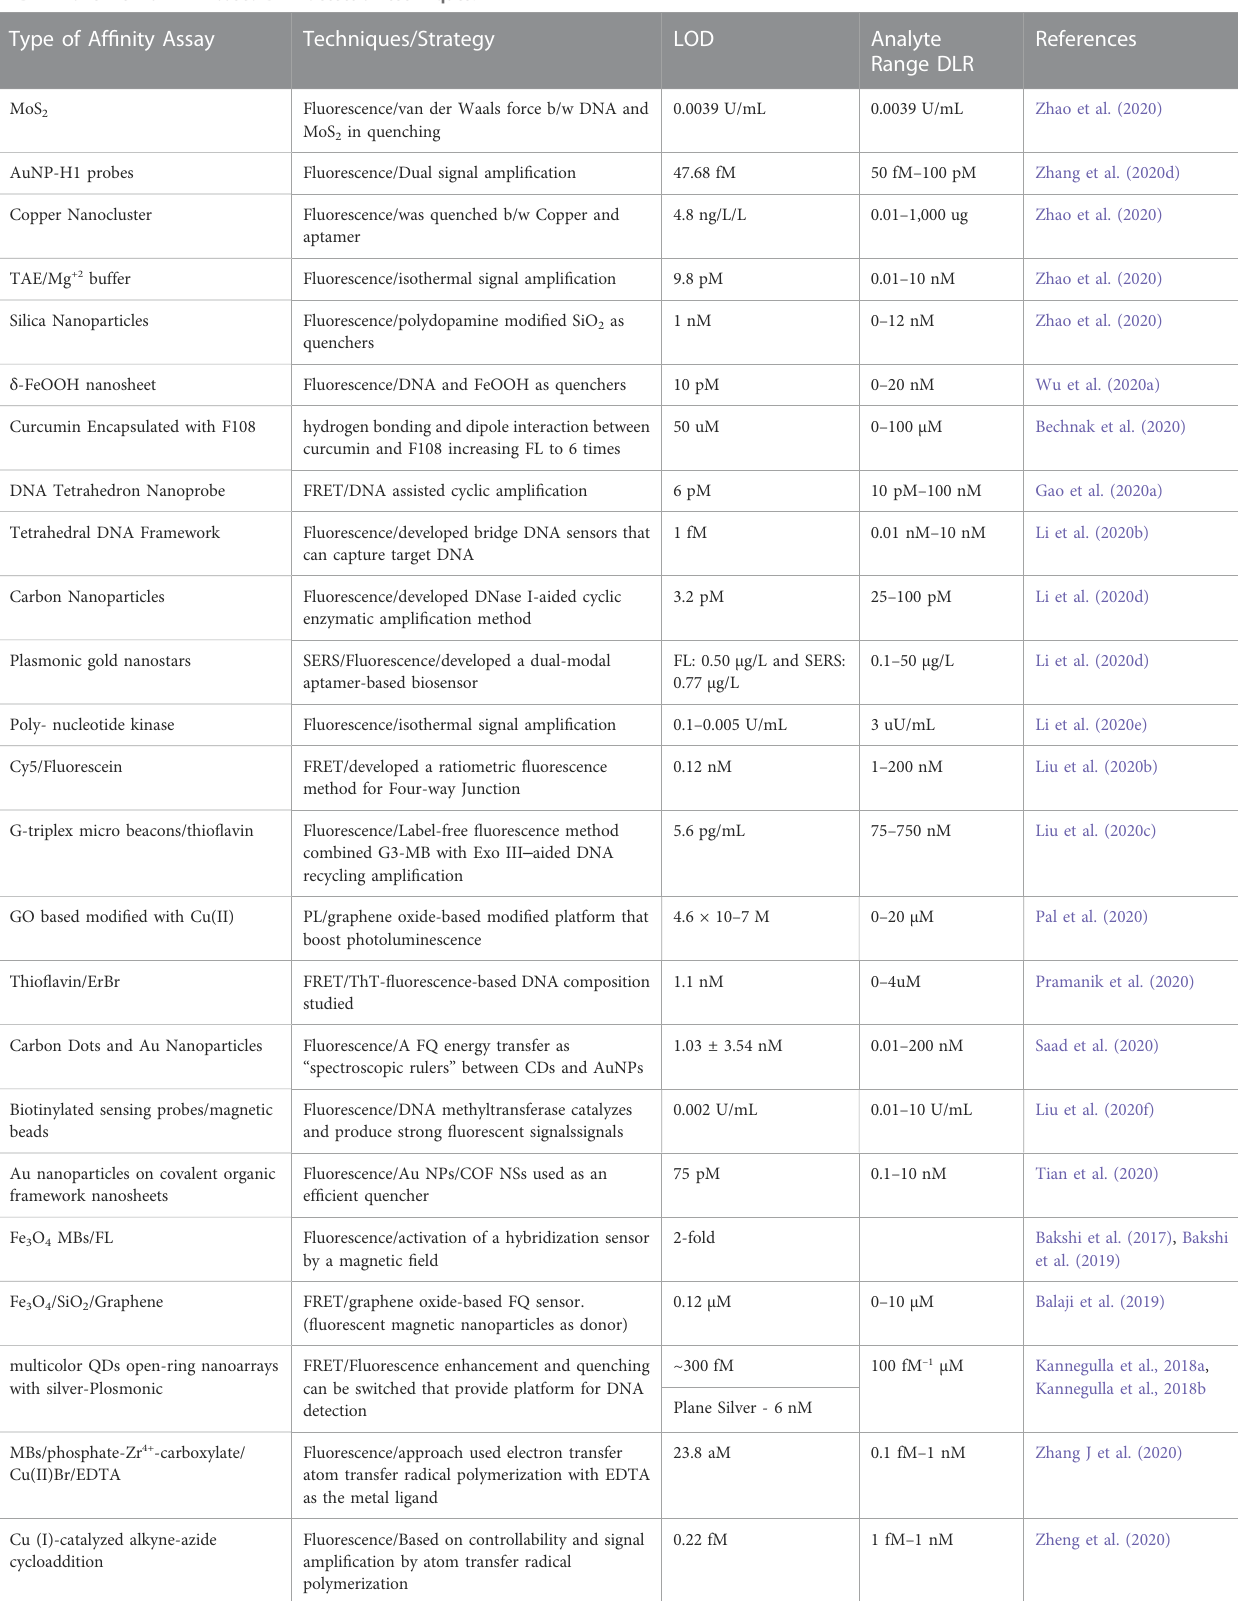
TABLE 1 Overview of FRET-based DNA detection